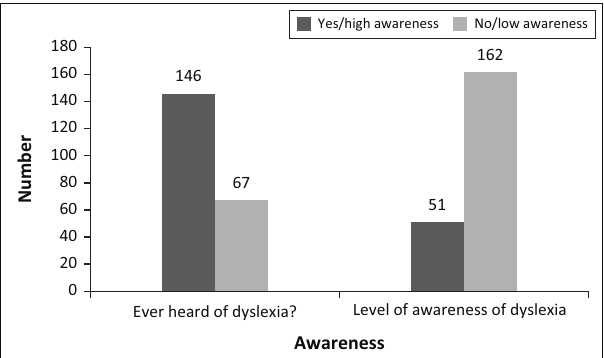
FIGURE 2: Bar chart showing primary school teachers’ responses on the question about dyslexia and their level of awareness about